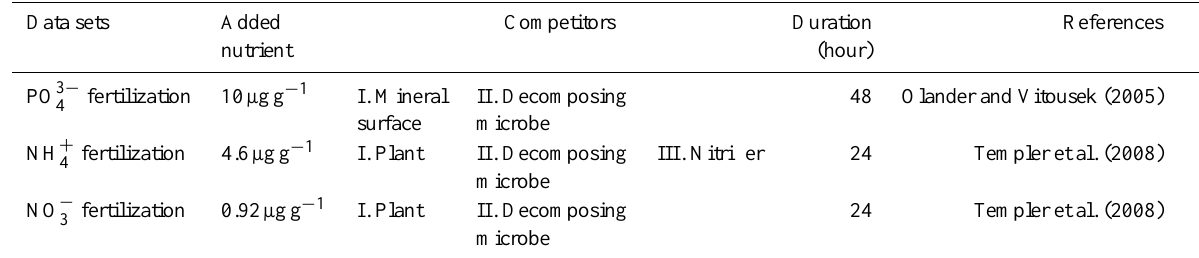
Table 5. Short-term (24 or 48h) fertilization experiments off NH + competition